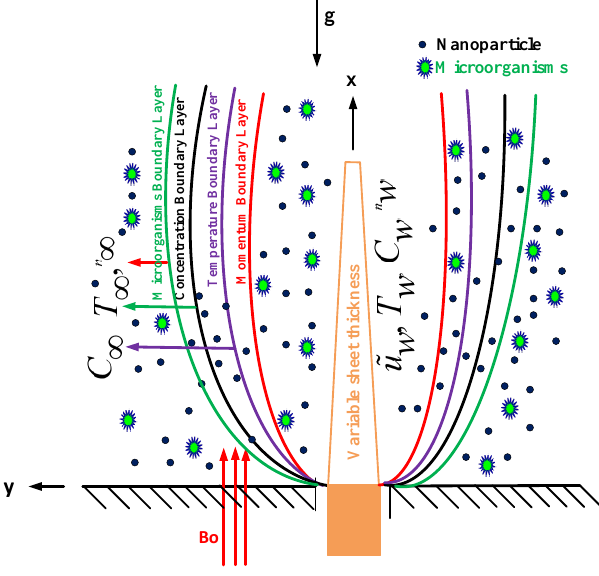
Figure 1. Physical representation of